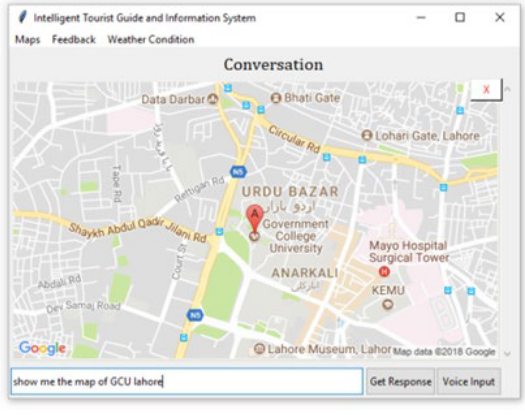
Fig. 7. Map result provided by the agent.